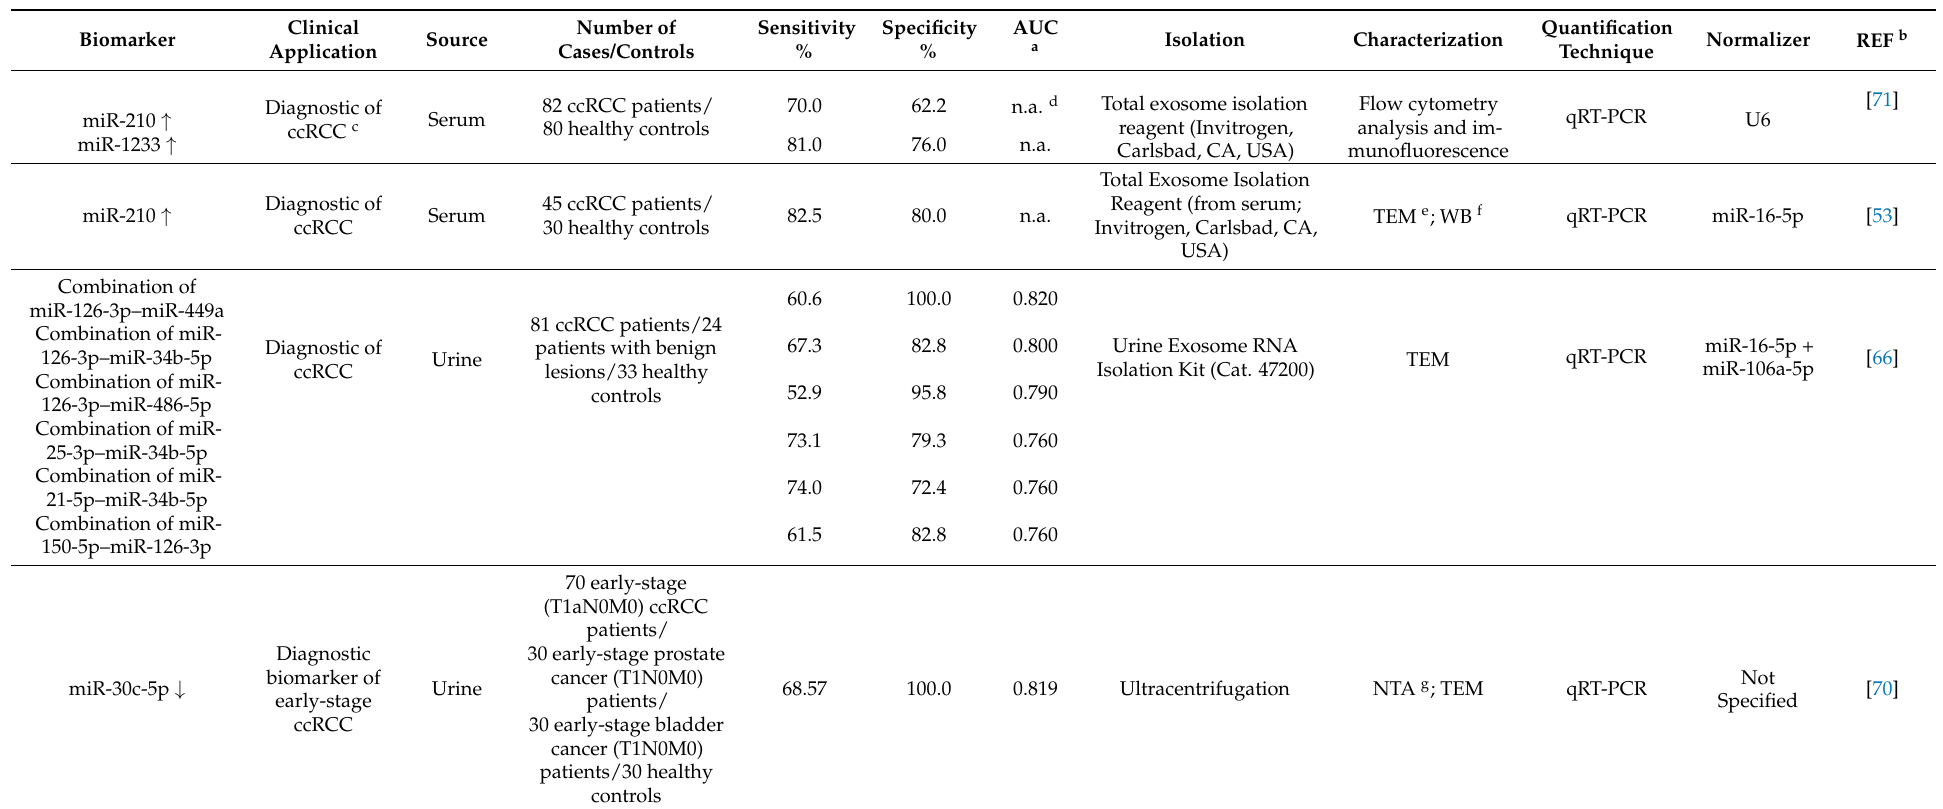
Table 3. Promising diagnostic exosomal miRNA in Renal Cell Carcinoma